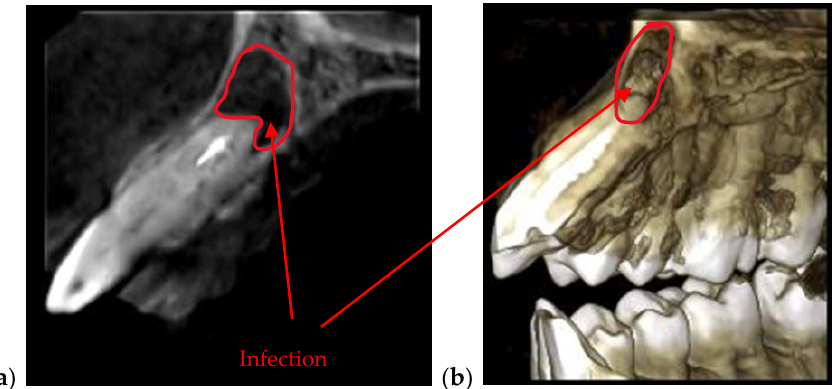
Figure 4. ( a ) Sagittal view and ( b ) 3D CBCT reconstruction of an infection formed at the tip of a tooth. Patient C.B.G., female, age 37 years, diagnosed with dental abscess.